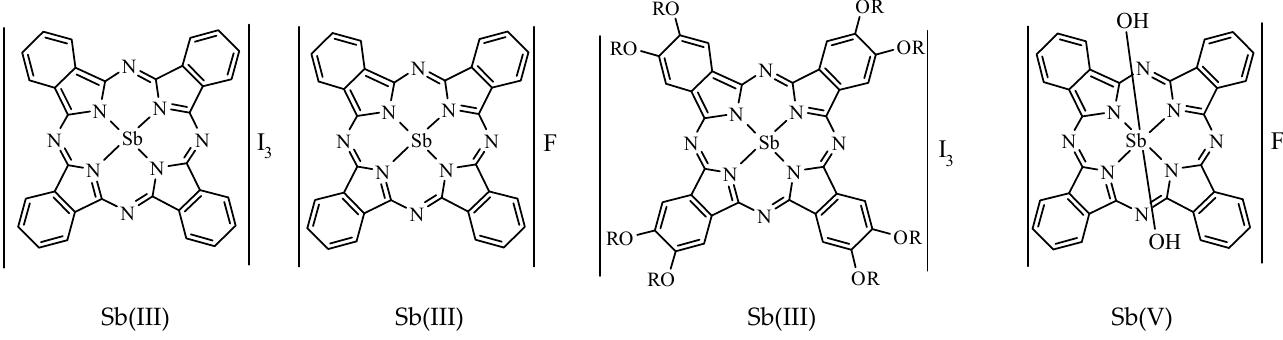
Scheme 2. Examples of some Sb(III) and Sb(V) phthalocyanines (-OR = C 6 H 5 O- or tert -bythylO-).